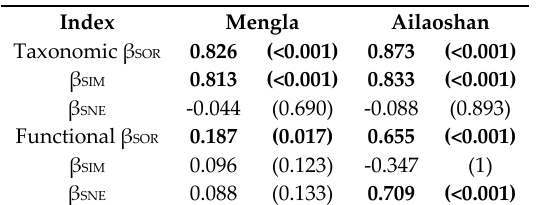
Table 2. Mantel correlations between beta diversity indices and elevational distance. β SOR = Sørensen dissimilarity index or total dissimilarity; β SIM = Simpson index or turnover-resultant dissimilarity; β SNE = nestedness-resultant dissimilarity. Correlations with significant p -values (in parentheses) are shown in